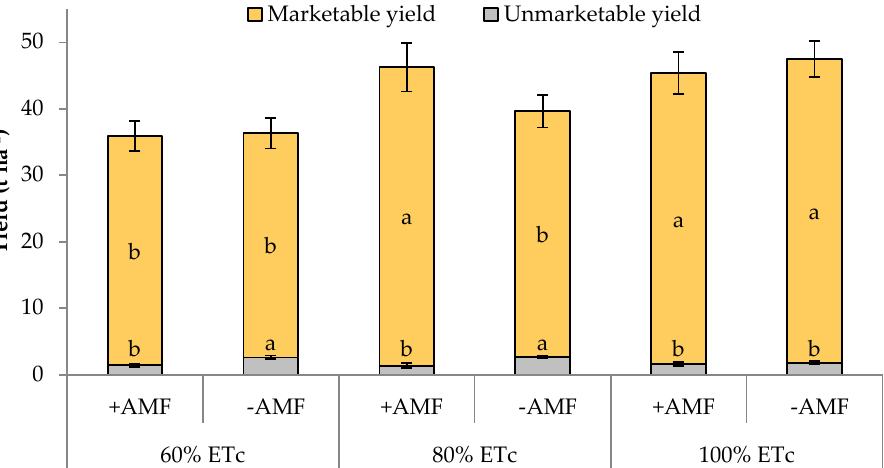
Figure 6. Effect of irrigation treatments and plant inoculation with arbuscular mycorrhizal fungi (AMF) on marketable and unmarketable yield of melon plants during two years of experiments (bars of the same color with different letters are significantly different at p < 0.05 according to the LSD test).